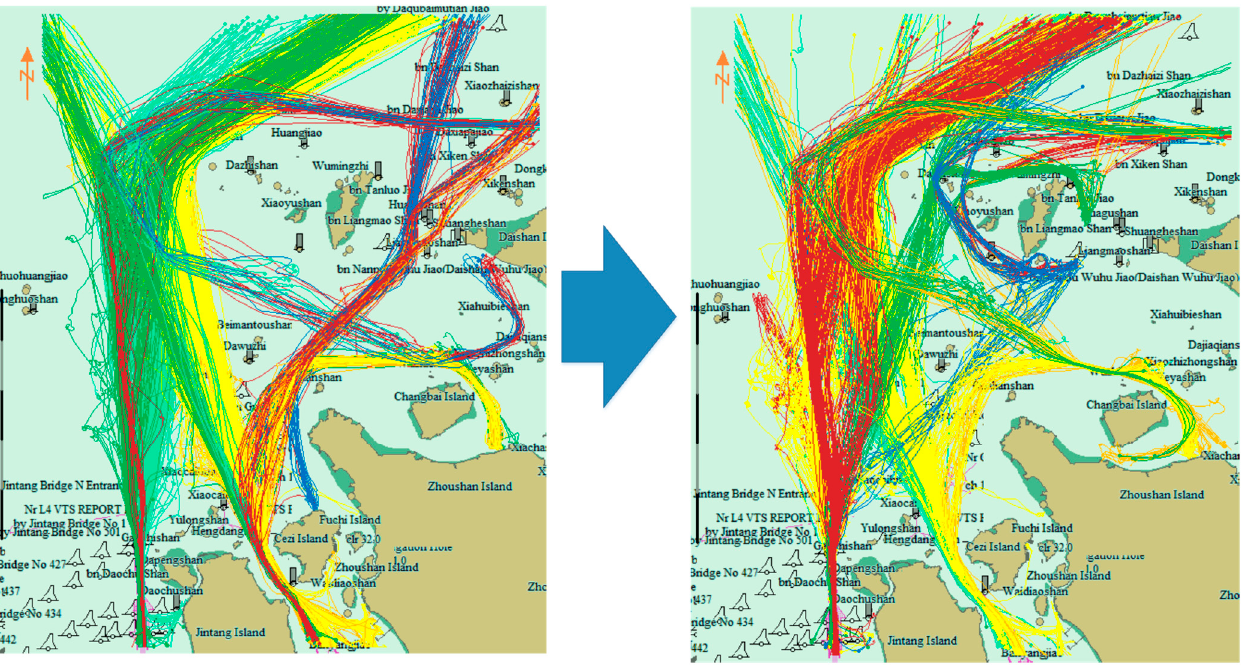
Figure 9. Clustering results before and after navigation prohibition. Different colors represent different clusters. After the construction of Yushan bridge, incremental clustering automatically makes the clusters across the bridge area